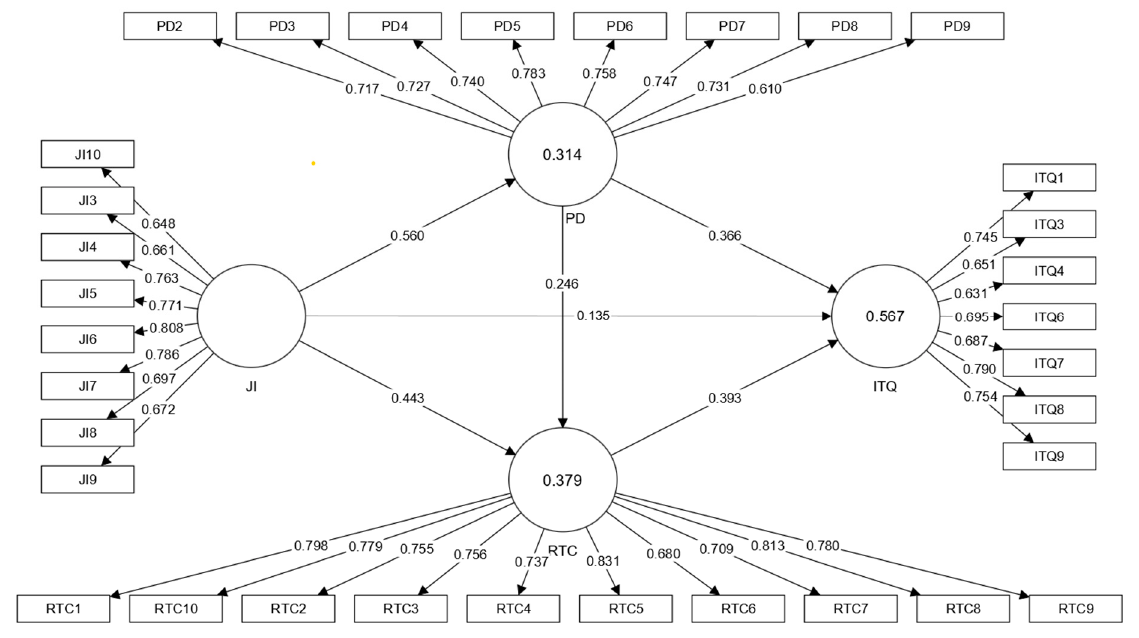
Figure 2. Measurement model.